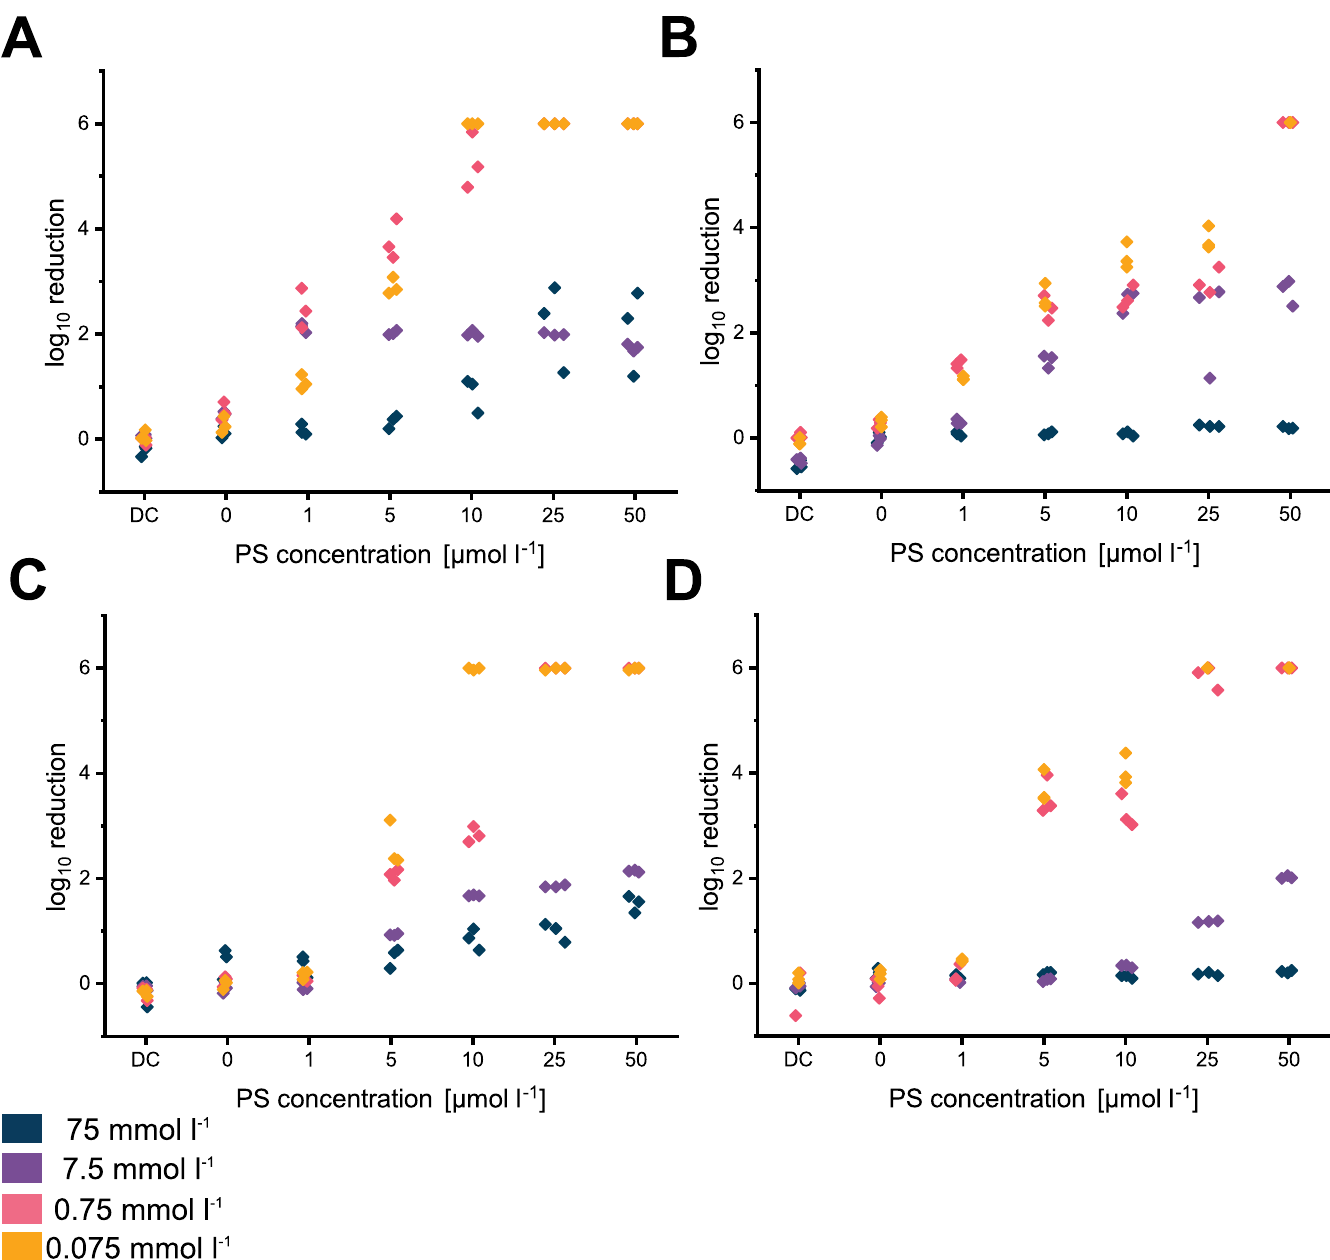
Fig 7. Logarithmic inactivation for P . aeruginosa data obtained for each experiment displayed as scatter plot. (A) shows results for sodium phosphate and FLASH- 02a, (B) displays the results for sodium carbonate and FLASH-02a. Obtained values for FLASH-06a are displayed in (C) for sodium phosphate and (D) for sodium carbonate. Y axes indicate the decadic logarithmic reduction and x axes indicate the PS concentration in μ mol l -1 or the dark control (DC). Different colors of the dots indicate the various sodium carbonate or sodium phosphate concentrations.